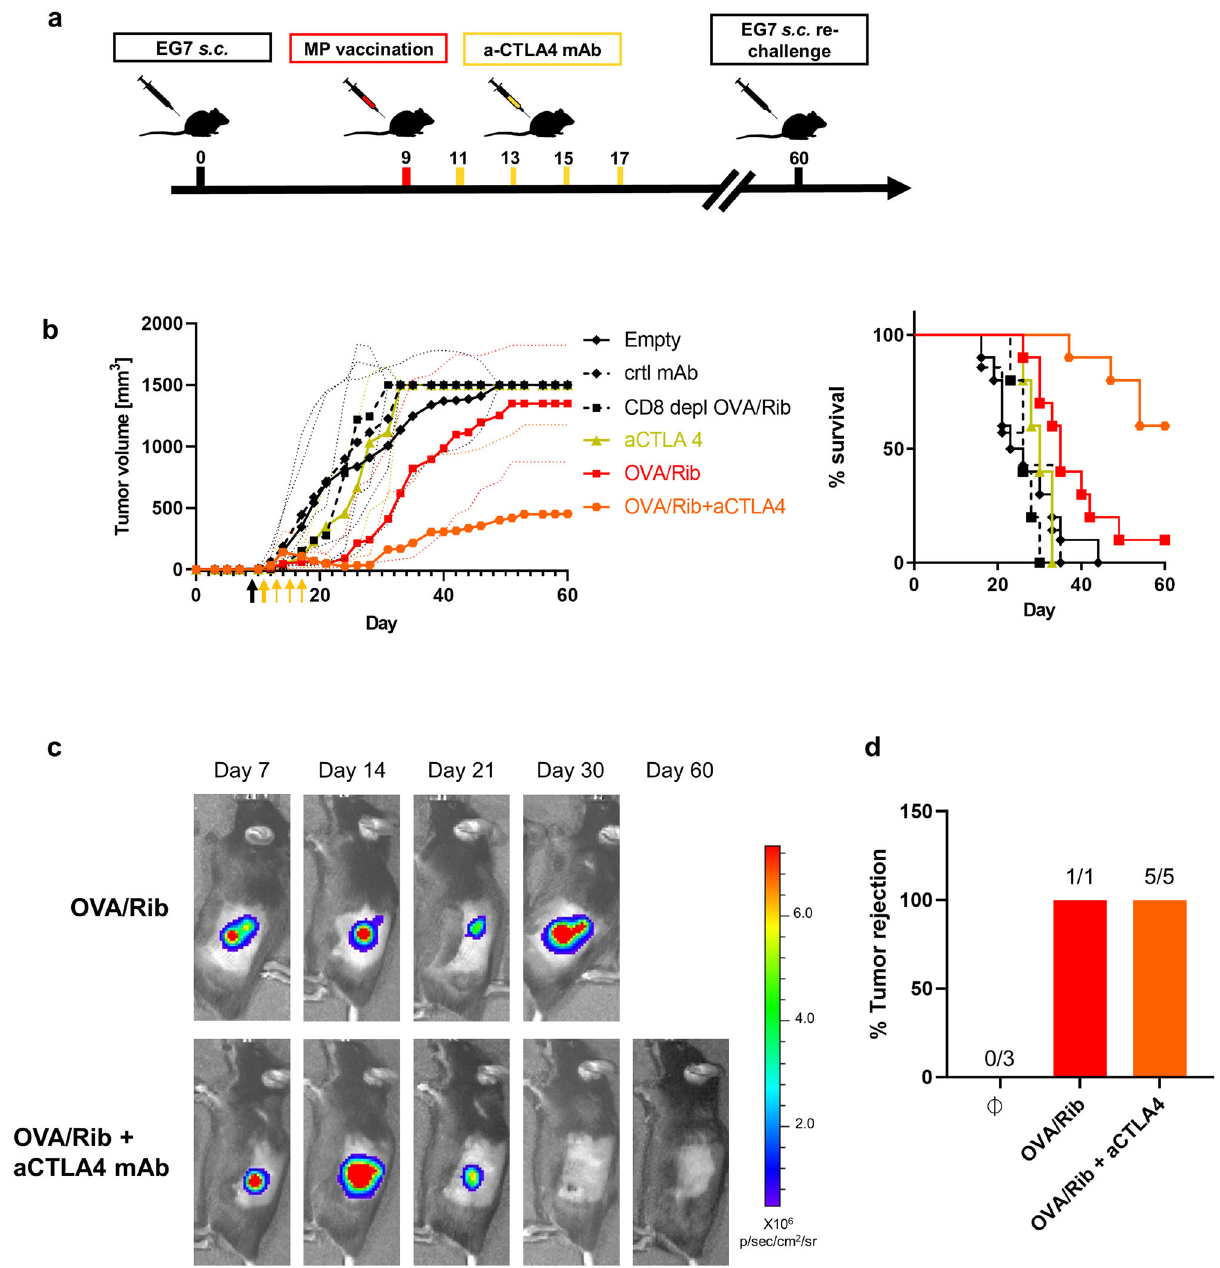
Fig. 6 CTLA-4 blockade enhances the therapeutic effect of cancer immunotherapy using PLGA-MP enabling tumor growth retardation and prolonged survival. a Scheme of PLGA-microparticles (MP) and immune checkpoint blockade combination therapy. b E.G7-OVA-luc + subcutaneous (s.c.) tumor- bearing C57BL/6J mice were treated with PLGA-MP (250 µ g OVA, 2.5 µ g Riboxxim, OVA/Rib, red squares, n = 10), PLGA-MP (250 µ g OVA, 2.5 µ g Riboxxim) in combination with systemic anti-CTLA-4 (250 µ g/mouse) (OVA/Rib + aCTLA4, orange hexagons, n = 10), or with anti-CTLA-4 monotherapy (250 µ g/mouse, aCTLA4, green triangles, n = 5). Mice immunized with respective isotype control monoclonal antibody (mAb) (ctrl mAb, black diamonds in dotted line, n = 5) or MP Empty (Empty, black diamonds, n = 10) served as control. CD8 + T-cell depletion (100 µ g/mouse of anti-CD8 mAb, CD8 depl OVA/Rib, black squares in dotted line, n = 5) was initiated 3 days before and on the day of microparticle injection and lasted until the end of the experiment with a weekly i.p. injection, demonstrating CD8 + T-cell indispensability in PLGA-MP-mediated tumor vaccination. Tumor growth is presented over time. Survival rates are expressed using Kaplan – Meier overall survival over time. Data are presented as mean ± S.D. with dotted lines in corresponding colors demonstrating individual data variances. Data were replicated in two independent experiments with a similar outcome. c Representative bioluminescence images of treated mice at indicated time points are shown. Scaling of the bioluminescent pseudo-color code is depicted and presented as photons/seconds/cm 2 /steradian (p/sec/cm/sr). d 60 days after tumor challenge, tumor-free mice of the MP-OVA/Riboxxim (OVA/Rib, red, n = 1) and the MP-OVA/Riboxxim plus anti-CTLA-4 combination therapy group (OVA/Rib + aCTLA4, orange, n = 5), as well as naive C57BL/6 mice ( n = 3, Ø) were subcutaneously re-challenged with 5 × 10 5 E.G7-OVA-luc + cells and tumor rejection was monitored for additional 30 days, demonstrating memory CD8 + T-cell formation causing rejection of re-implanted tumor